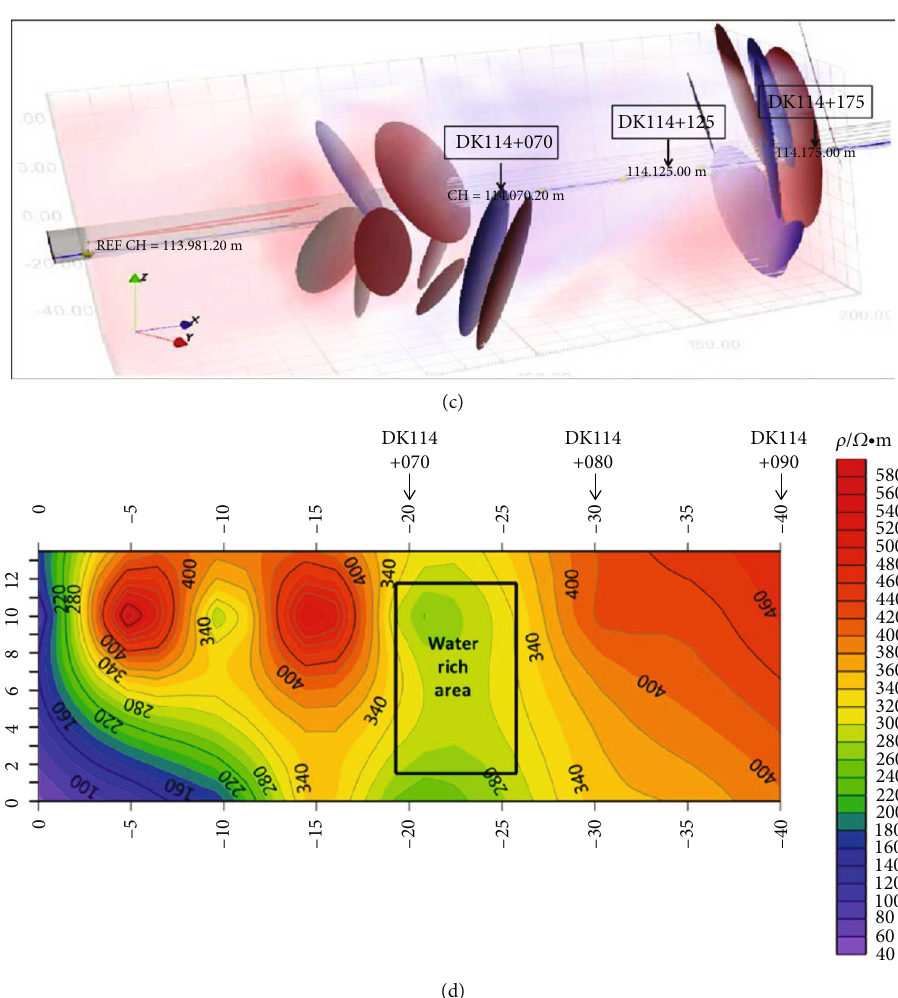
Figure 3: Integrated geological forecast results: (a) physical and mechanical parameters; (b) V (c) results of geological radar; (d) results of transient electromagnetic method.